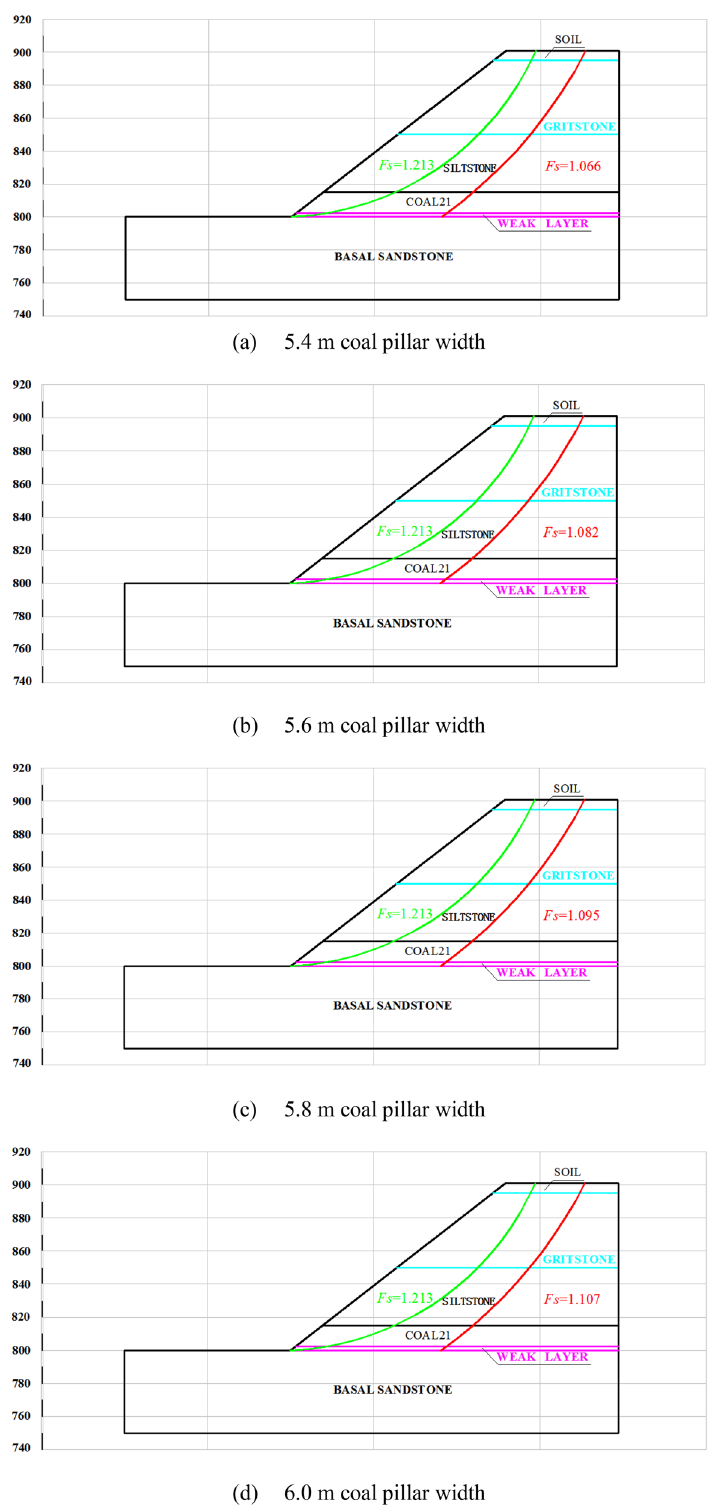
Figure 10. Failure paths for different coal pillar